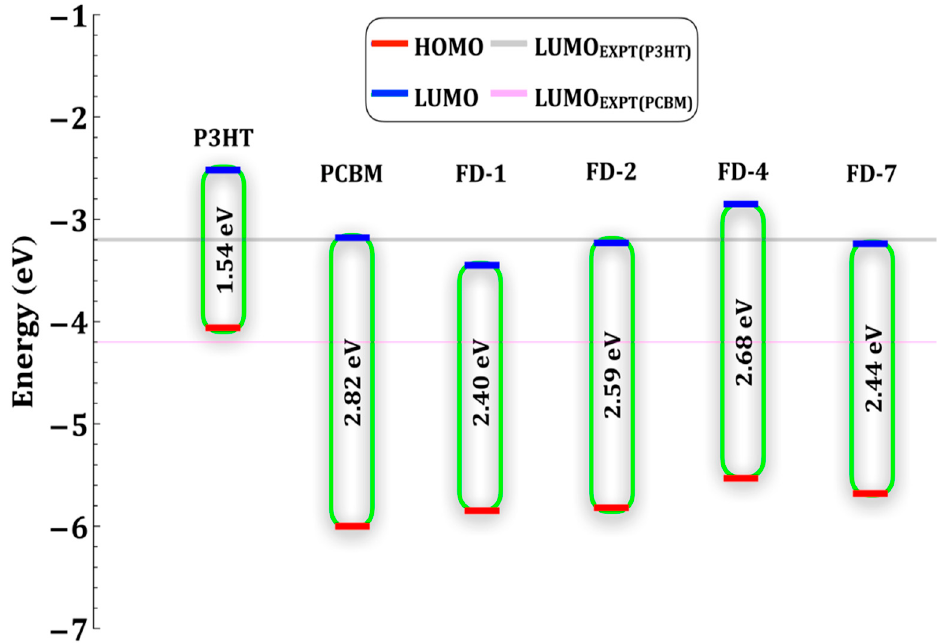
Figure5. ComputedenergydiagramofthefourFDsalongwith[6,6]-phenyl-C61-butyricacidmethylester Figure 5. Computed energy diagram of the four FDs along with [6,6]-phenyl-C61- (PCBM)andP3HT.AllthevaluesobtainedwiththeuseofPBE / butyricacidmethylester (PCBM) and P3HT. All the values obtained with the use of PBE/6-31G(d,p) level of theory in the gas phase.